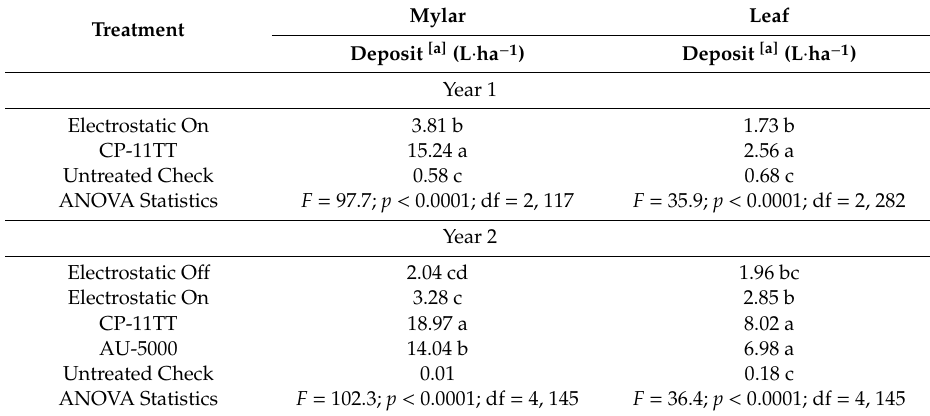
Table 4. Mean spray volume deposition (L · ha − 1 ) of dye tracer on an artificial sampler and on weed